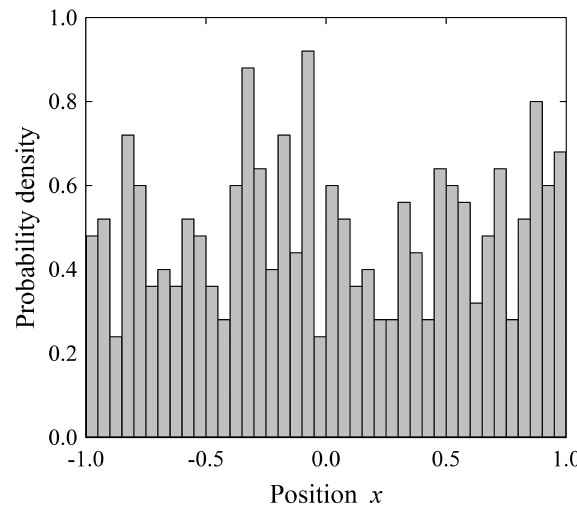
Figure A3. Histogram of particle positions x at time t → ∞ for one system showing that with a modest number of particles representing a rarefied condition this histogram is irregular and discontinuous; in this example N =